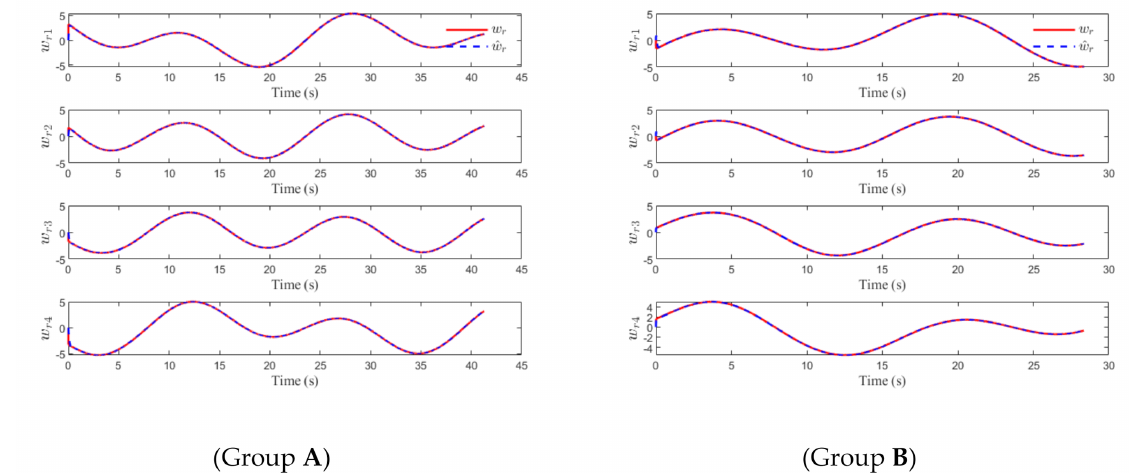
Figure 8. Actual and estimated values of external disturbance in the direction of LOS.